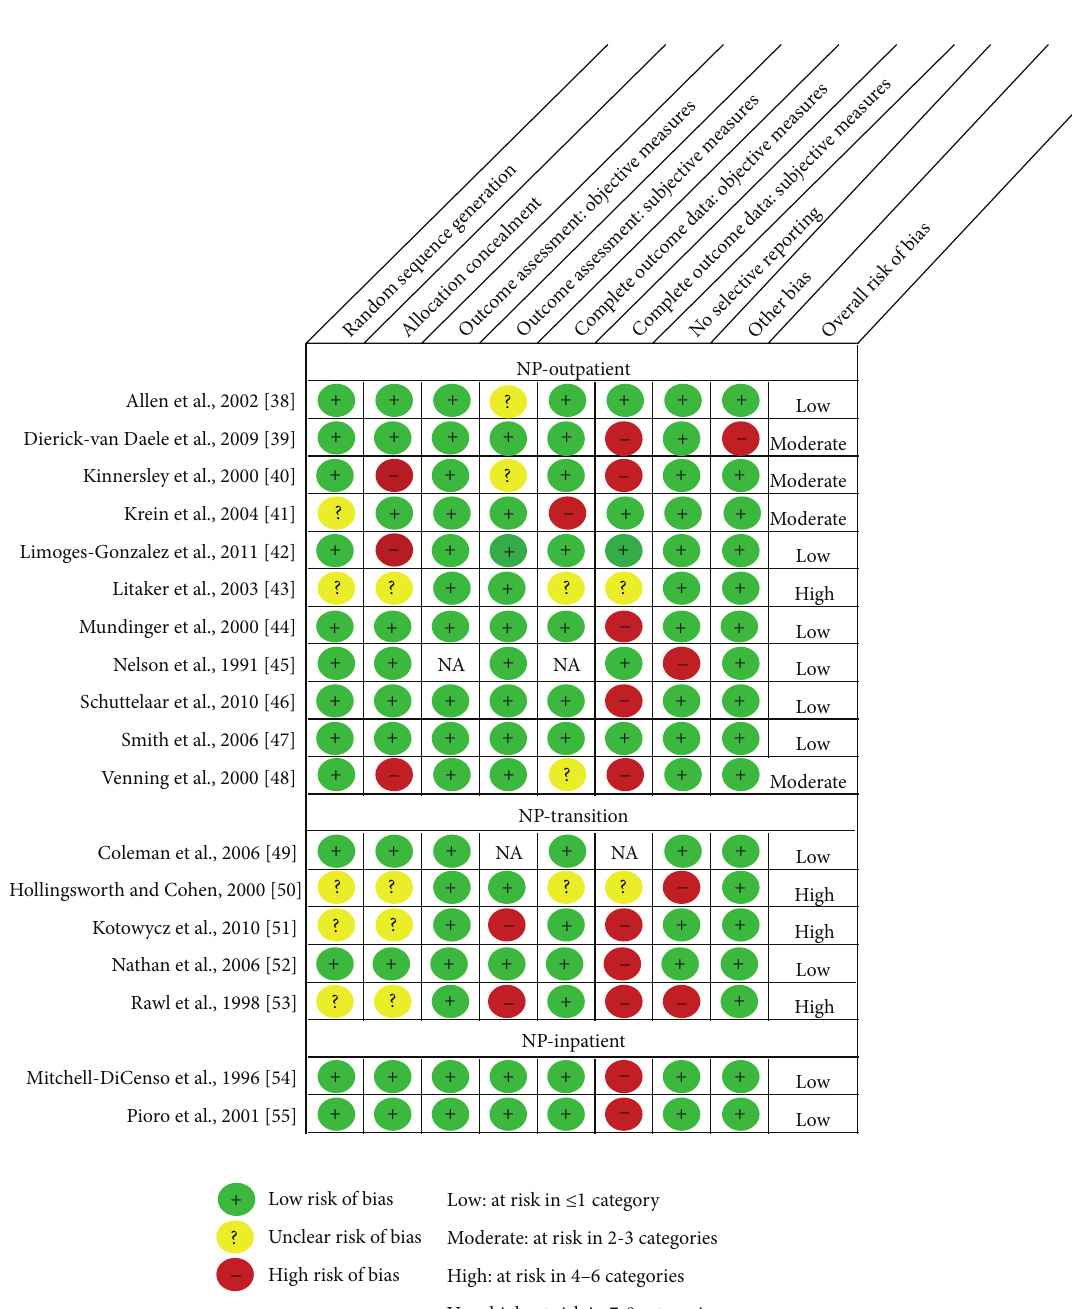
Figure 2: Risk of bias assessment of NP studies ( 𝑛 = 18